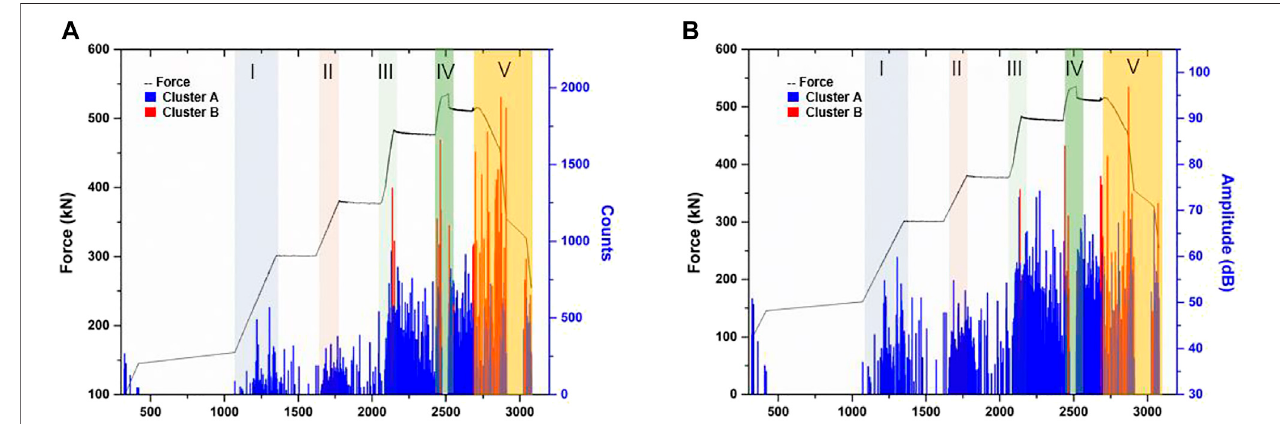
FIGURE7| TemporaldistributionsofAEparameterscount (A) andamplitude (B) oftwoclassi fi edAEsignalscorrespondingtotwocrackingmodesinrock.Cluster A and B are indicated with blue and red respectively.